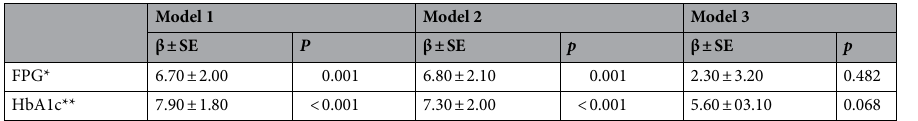
Table 2. Association of albumin-to-creatinine ratio for each increase of 1-SD in the levels of HbA1c and FPG. Model 1: Not adjusted. Model 2: Adjusted for age, sex, alcohol consumption, TC, HDL-cholesterol, TG, BMI and WC. Model 3: * Subsequently adjusted for HbA1c in addition to the model 2 variables; ** Subsequently adjusted for FPG in addition to the model 2 variables. SD, standard deviation; β, regression coefficient; SE, standard error; BMI, body mass index; FPG, fasting plasma glucose; HbA1c, glycated hemoglobin A1c; HDL-c, high density lipoprotein cholesterol; TG, triglyceride; WC, waist circumference.